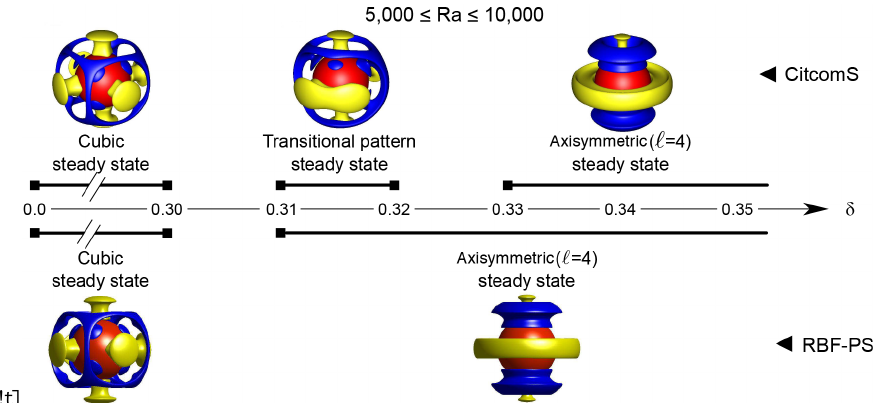
Figure 2. Final convection patterns resulting from perturbations, δ , to the cubic initial condition as obtained with CitcomS (top row) and the RBF-PS method (bottom row). Diagram is valid for 5000 ≤ Ra ≤ 10 000. The isosurfaces show the residual temperature δT = T (r,θ,λ) − h T (r) i , where h T (r) i is the horizontally average temperature. Blue (downwelling – descending motion) and yellow (upwelling – ascending motion) isosurfaces are for δT equal to − 0.15 and 0.15, respectively. The red solid sphere is the inner boundary.